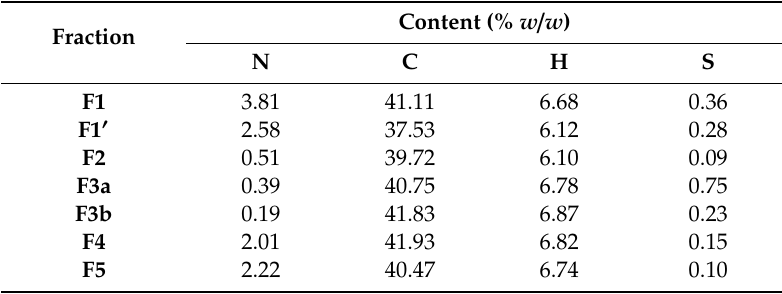
Table 2. Elemental composition of the crude polysaccharidic fractions.